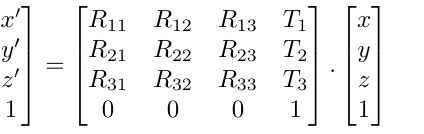
blob/master/packages/lifting/